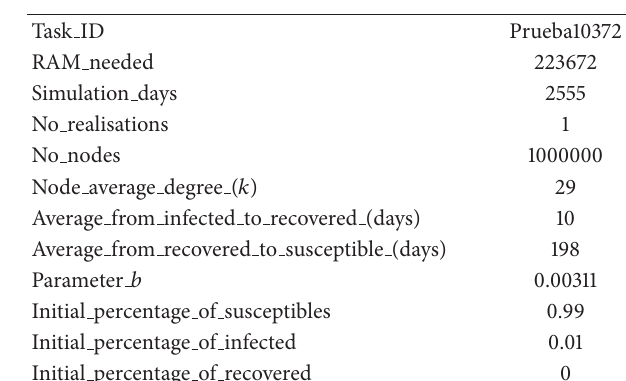
Table 1: An example of task file for the Sisifo